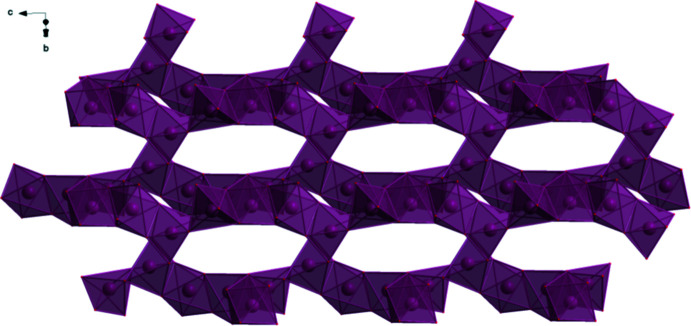
View of the Na/O layers in (I), viewed down [10].